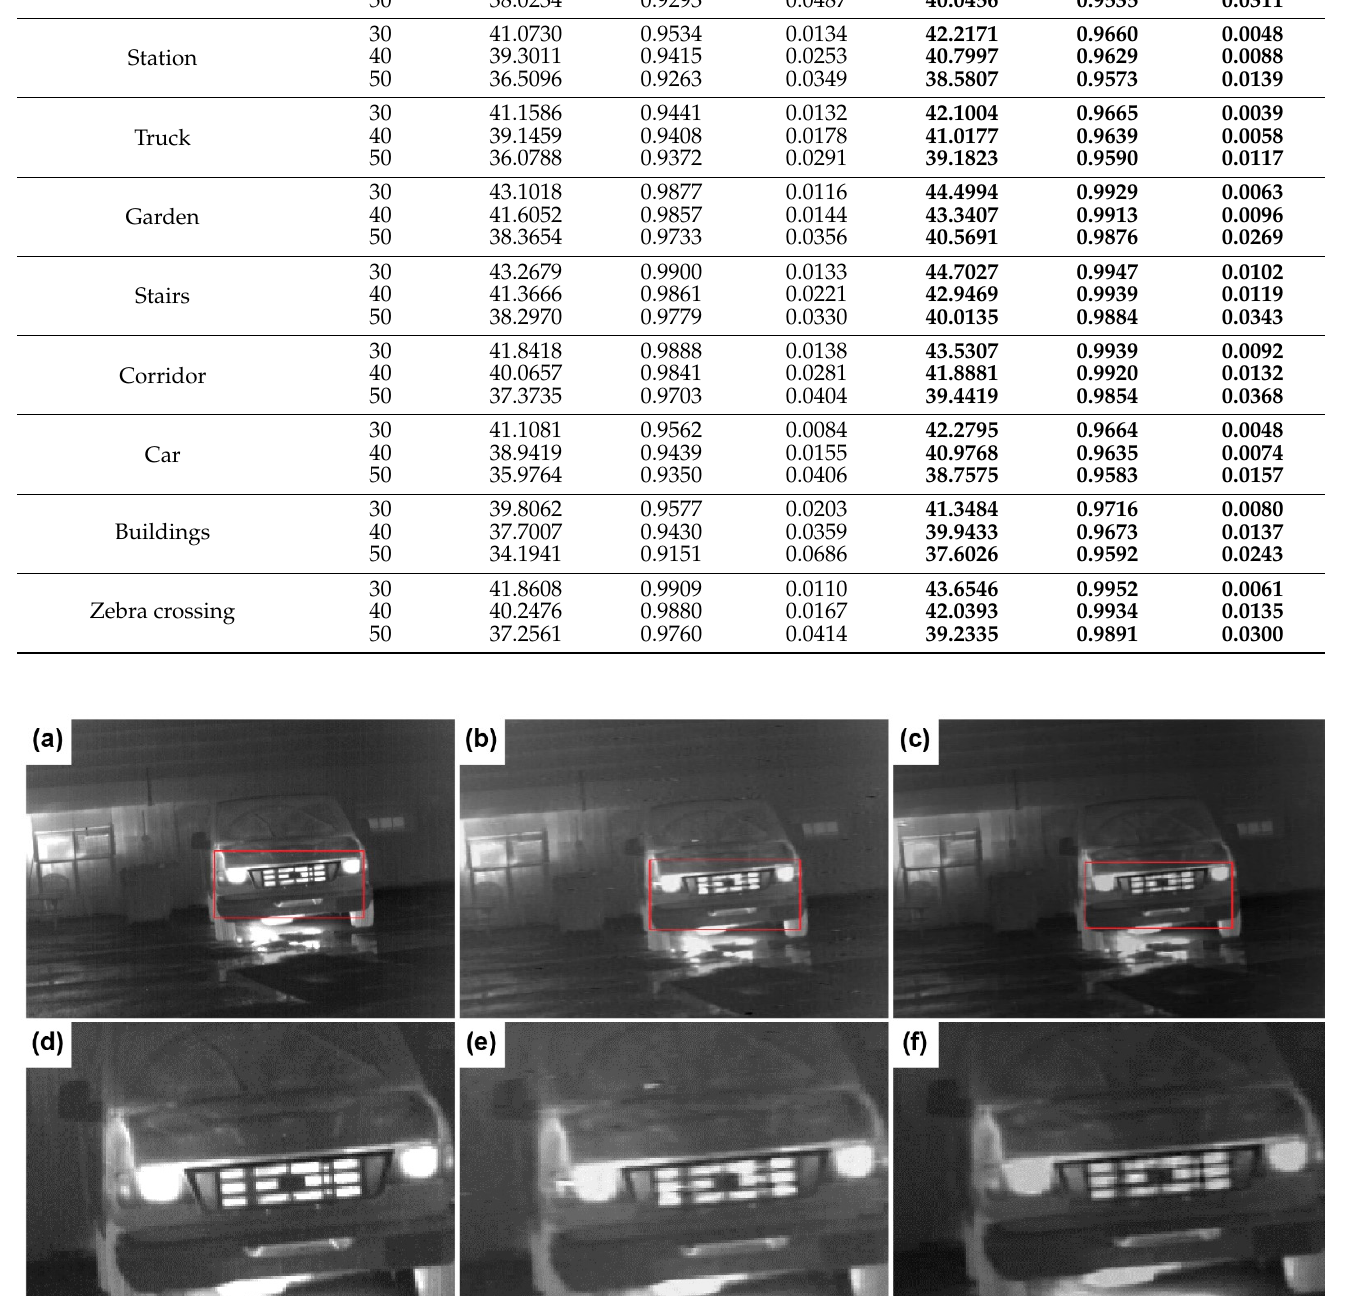
Figure 7. A comparison of deblurring effects of the two models on a truck image. ( a ) The original truck image, ( b ) the image deblurred using Lp_LOGS, and ( c ) the image deblurred using Lp_HOGS. ( d – f ) The local enlarged images of the red boxes from ( a – c ), respectively.